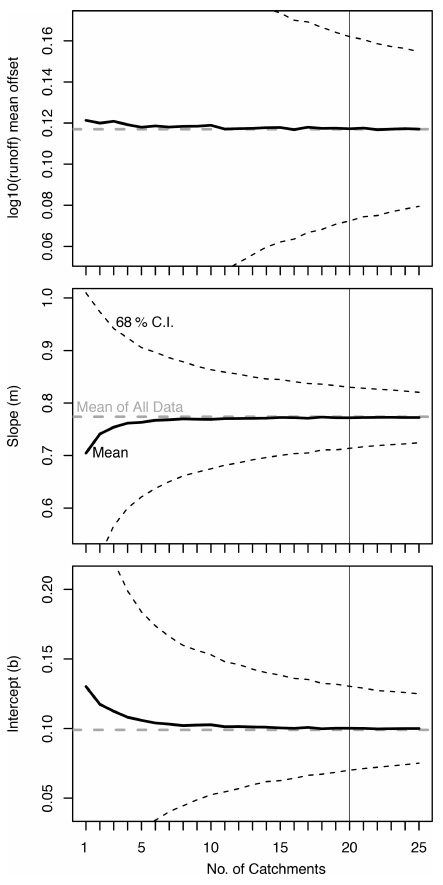
Figure 7. Bootstrap uncertainty of bias correction. Plotted vs. the number of catchments is the mean and confidence interval (68%) log10(runoff) offset, the slope, and intercept of the bias correction determined via random sampling at the catchment level without re- placement. The vertical line at 20 catchments is the uncertainty re- ported in the text where all three coefficients asymptotically con- verge to the mean values determined using the entire dataset.